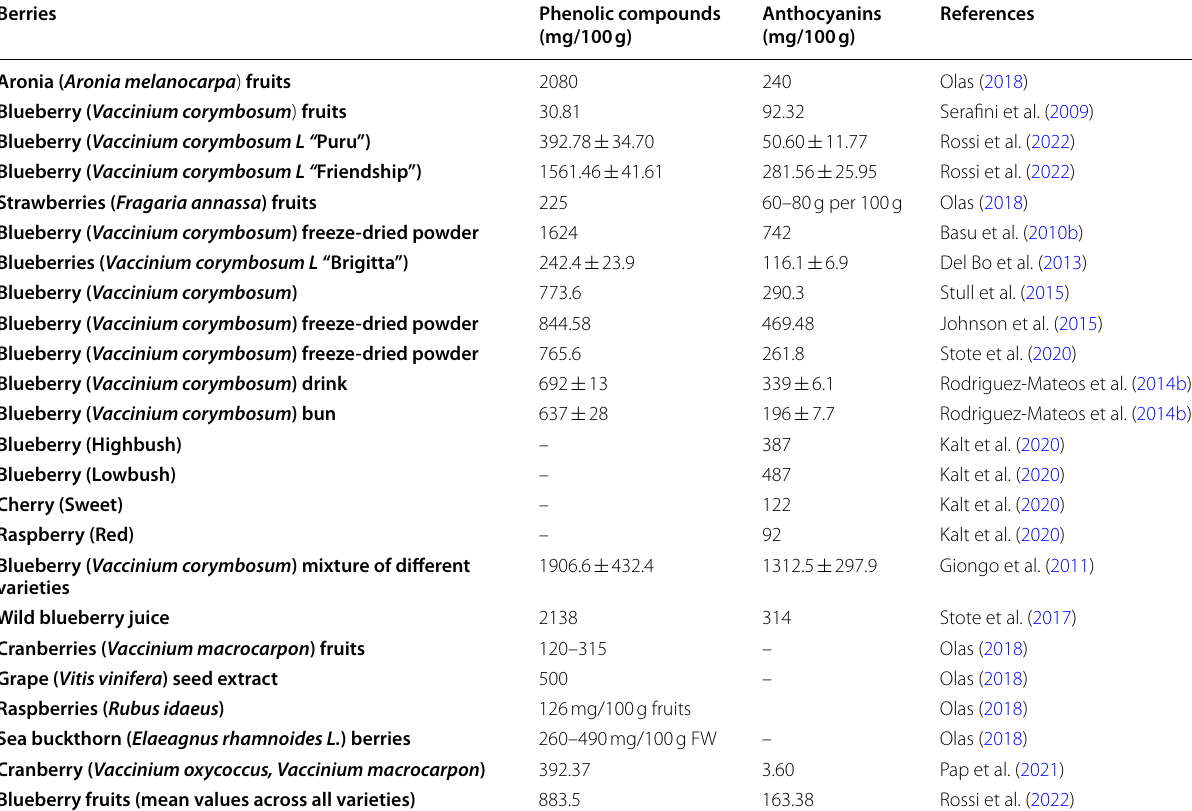
Table 1 The concentration of total phenolic compounds and anthocyanins in different berries and their